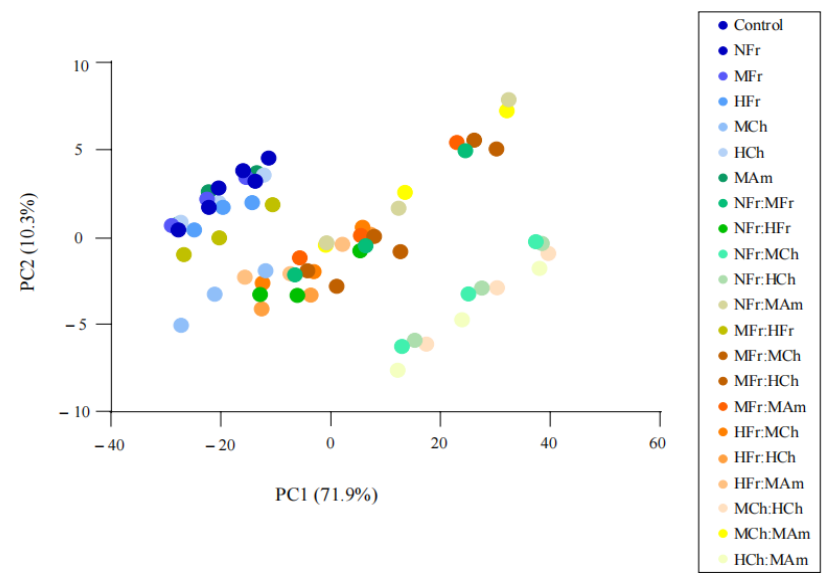
Figure 2. PCA plot of the electronic tongue detection results of wines of Vitis amurensis .